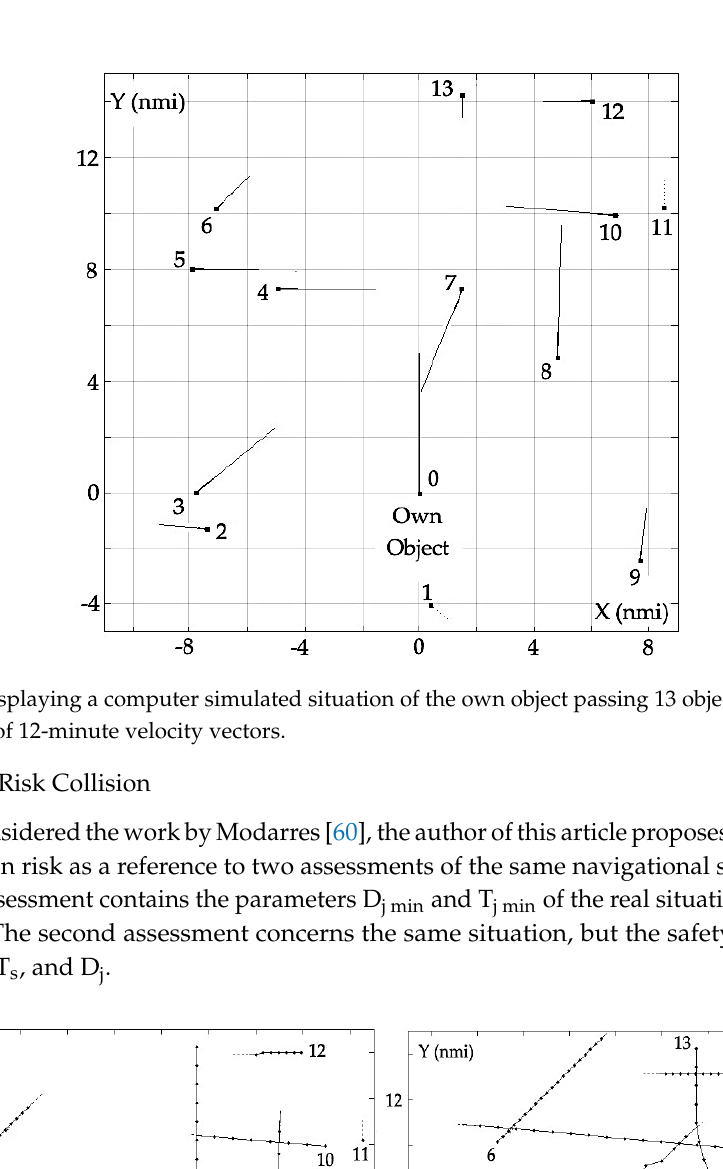
Figure 7. Object game trajectories calculated according to the pg nc algorithm of the non-cooperative positional game control: on the left — with good visibility at sea, with the final payoff of the game ε f = 1.3 nmi achieved, assessing the deviation safe trajectory from reference cruise route; on the right — with limited visibility at sea, with the final payoff of the game ε f = 5.8